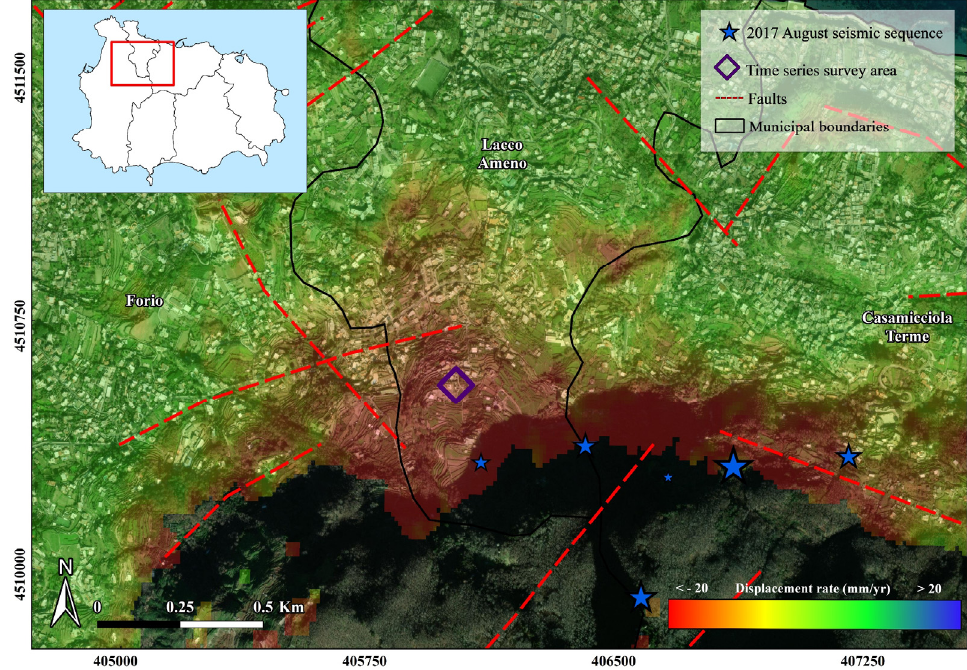
Figure 11. Detail of the maximum deformation zone and location of the area examined through the time series. Sentinel-1A vertical displacement map, epicentres [9] and faults [10] are also visible.